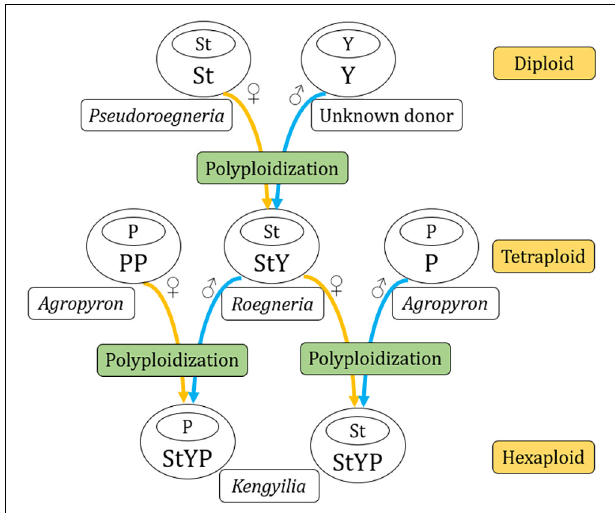
FIGURE 4 | A diagram of lineage relationships among genera Kengyilia , Roegneria , and Agropyron .